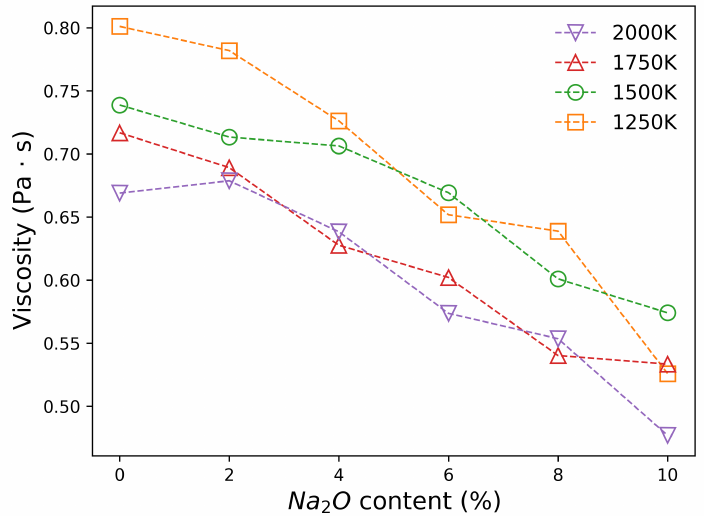
Figure 12. Simulated shear viscosity with NEMD as a function of Na 2 O weight percentage for Na 2 O–CaO–Al 2 O 3 –SiO 2